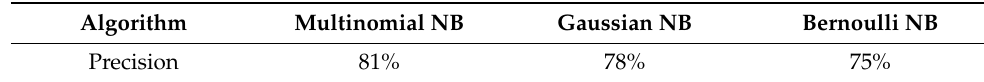
Table 2. Precision for the Democrat data